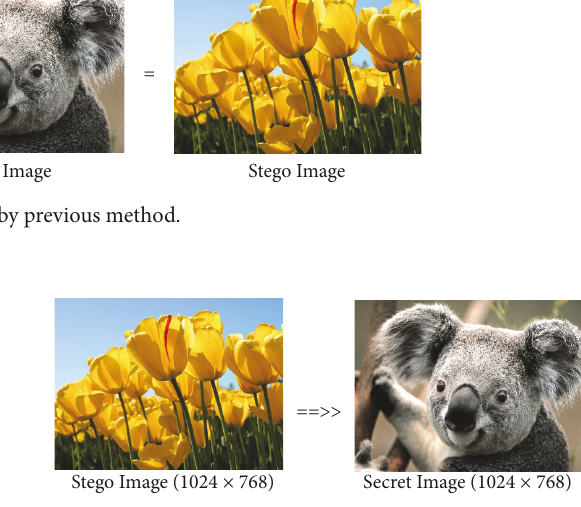
Figure 9: Decoding by max-plus algebra.